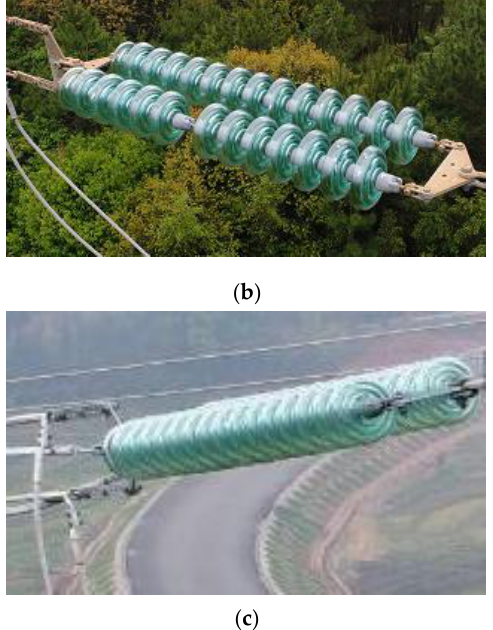
Figure 14. Insulator detection at different angles. ( a ) Two insulators without overlapping parts, ( b ) Two insulators with partial overlap, ( c ) Two insulators with complete overlap.